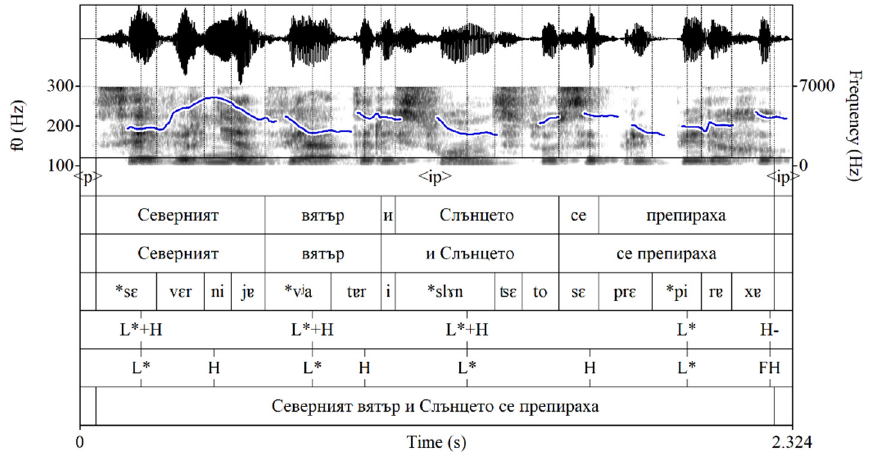
Figure 2. The utterance Северният вятър и Слънцето се препираха (‘The North Wind and the Sun were disputing’), pronounced as a single intermediate phrase by a Bulgarian speaker. Labeling of